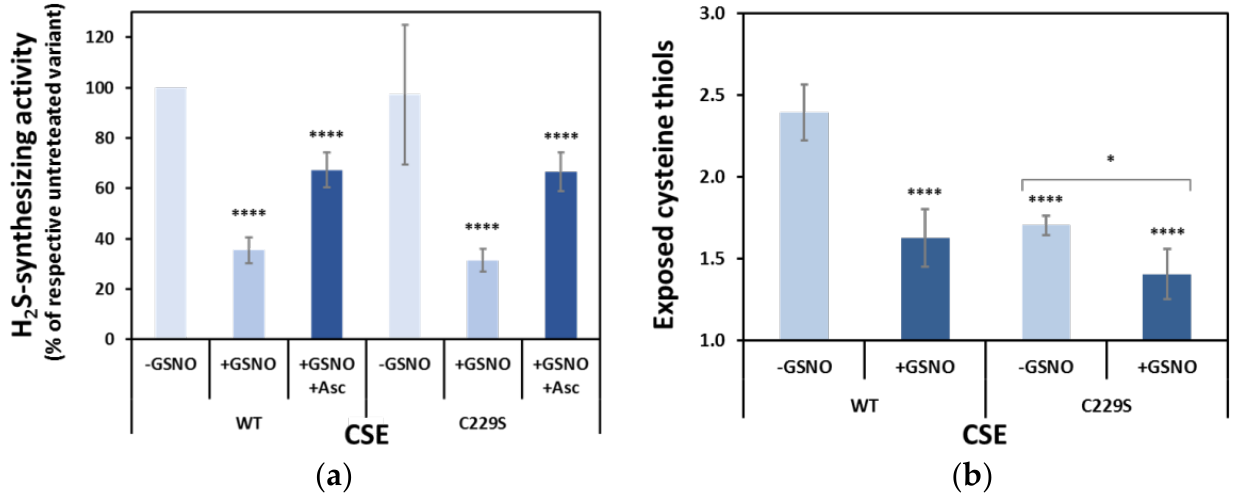
Figure 3. Effect of C229S substitution on GSNO-inhibition. ( a ) H 2 S production by GSNO-treated and GSNO/Asc-treated WT and C229S CSE, measured as described in the legend to Figure 1. Relative activities were normalized to the respective unreacted CSE variant, except for ( a ), where the activity of untreated C229S was normalized to that of untreated WT CSE. Ascorbate was added to the GSNO-modified CSE (+GSNO +Asc). Error bars represent the standard error (SE), where n ≥ 5. ( b ) number of free exposed cysteines in CSE as determined using DTNB for as isolated CSE (-GSNO) and upon incubation with GSNO (+GSNO). Error bars represent the standard error (SE), where n ≥ 4. One-way ANOVA was employed to compare differences between groups in both graphs, **** p < 0.0001. Student’s t -test was used to compare the exposed cysteine thiols of the C229S variant ( b ) with or without GSNO, * p < 0.05.